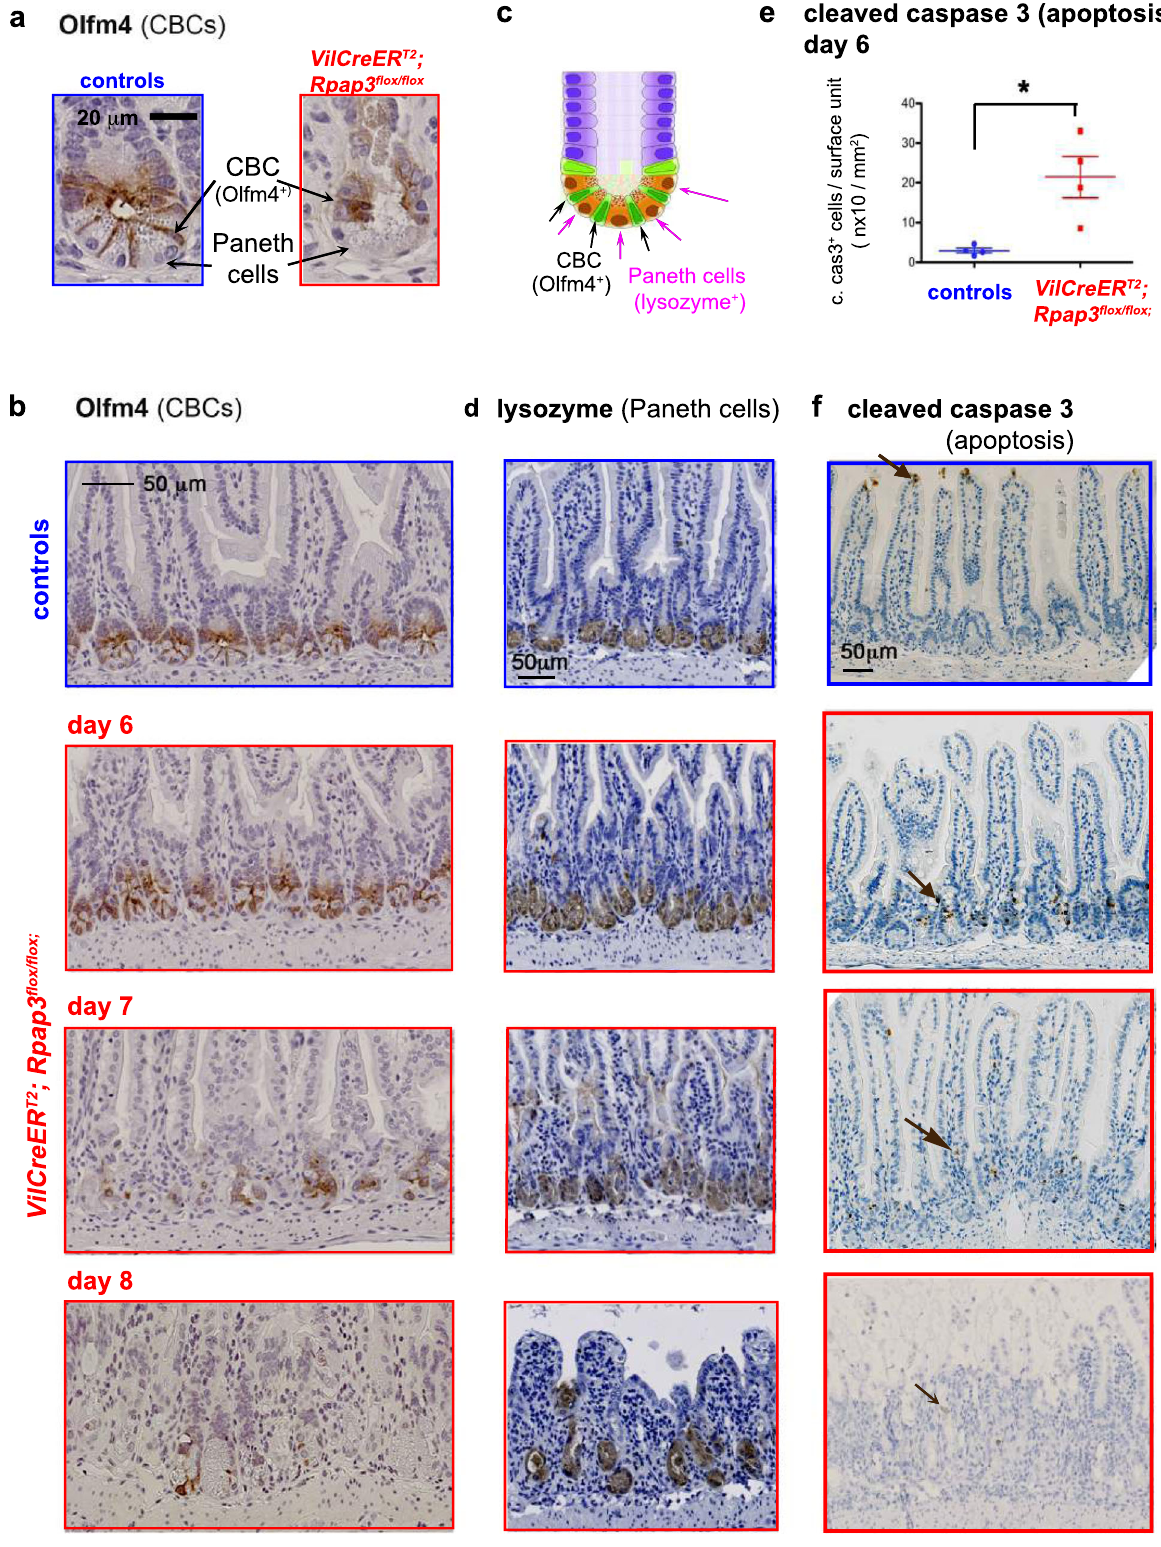
Transcriptomic analyses showed a signi fi cant enrichment of mRNAs encoding RUVBL1, RUVBL2, and RPAP3 in human primary colorectal tumors ( n = 380) as compared to normal tis- sue ( n = 51), in agreement with a previous report on a smaller cohort 50 (Fig.